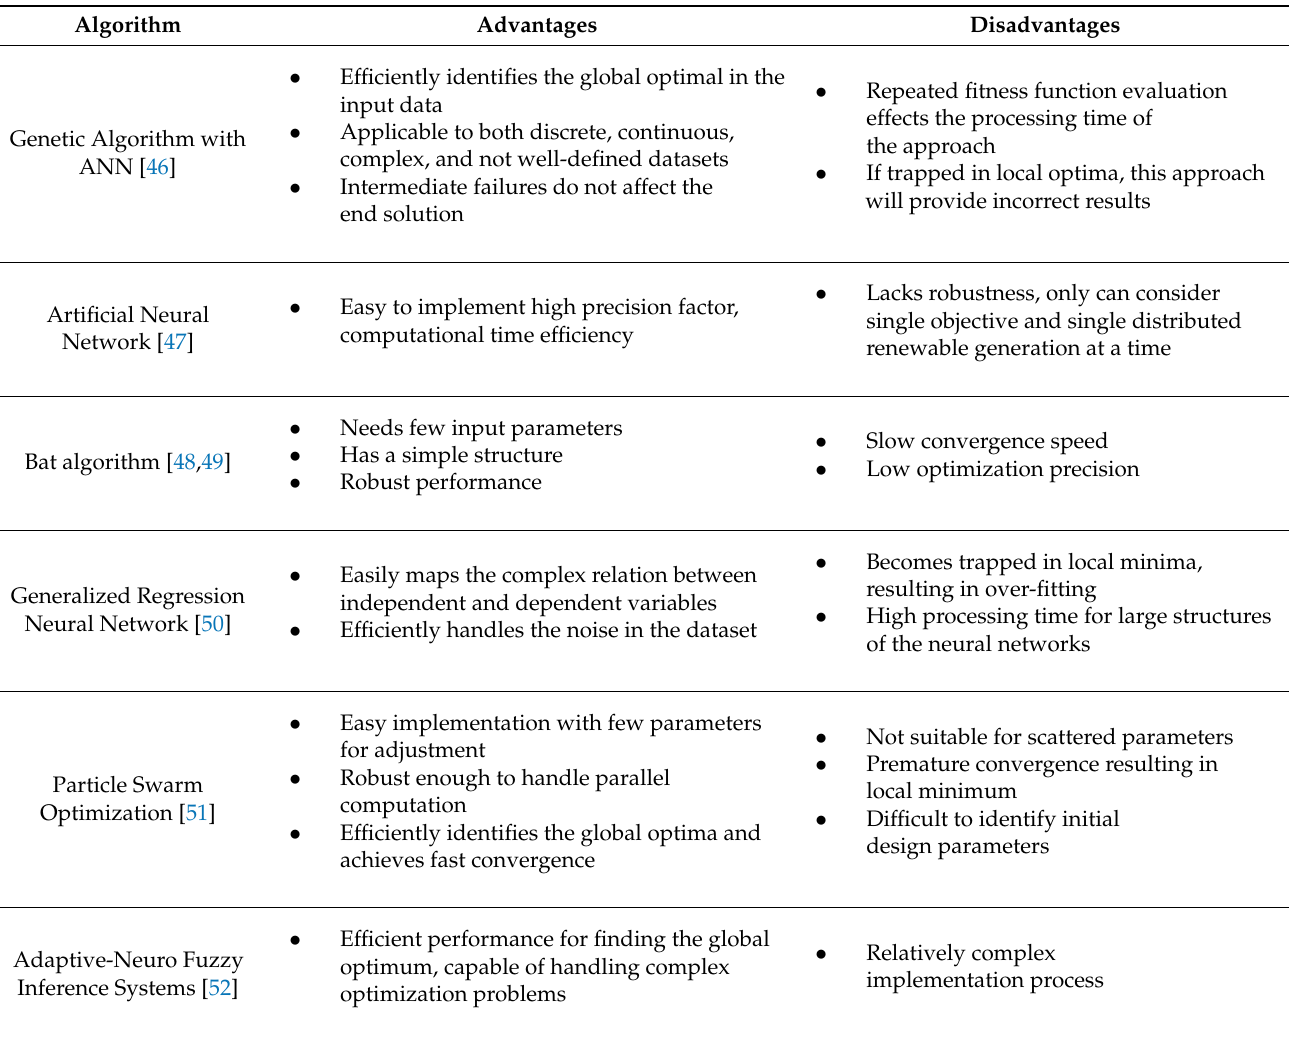
Table 3. Methods for optimum sizing of PV